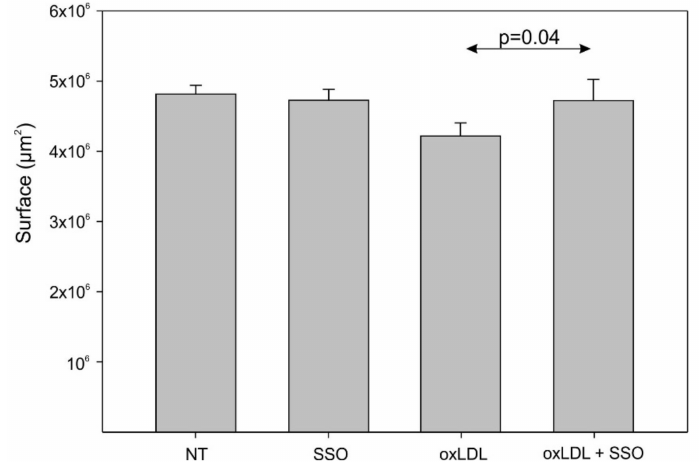
Figure 5. Detroit 562 cells’ migration under oxLDL and SSO treatment. There is no significant difference between the control cells (NT) and the SSO-treated cells, but SSO significantly overcomes the effect of oxLDL on cell migration ( t -test, p = 0.04, n = 6) (mean ± SD; o: datapoint) (NT: cells without